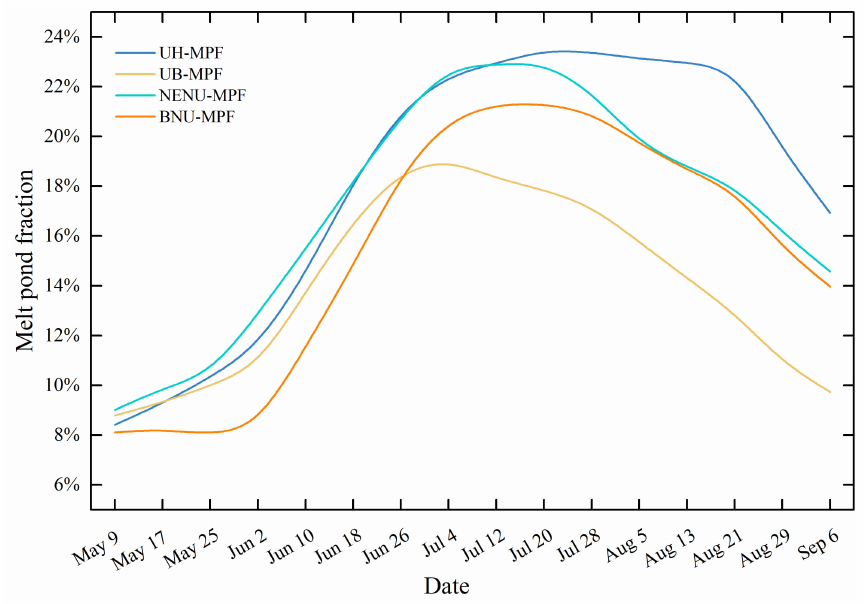
Figure 17. Multi-year mean temporal evolution of the MPF derived from the UH-MPF, UB-MPF, NENU-MPF, and BNU-MPF datasets from May to September during 2003–2011. Only the pixels with valid MPF values were used.